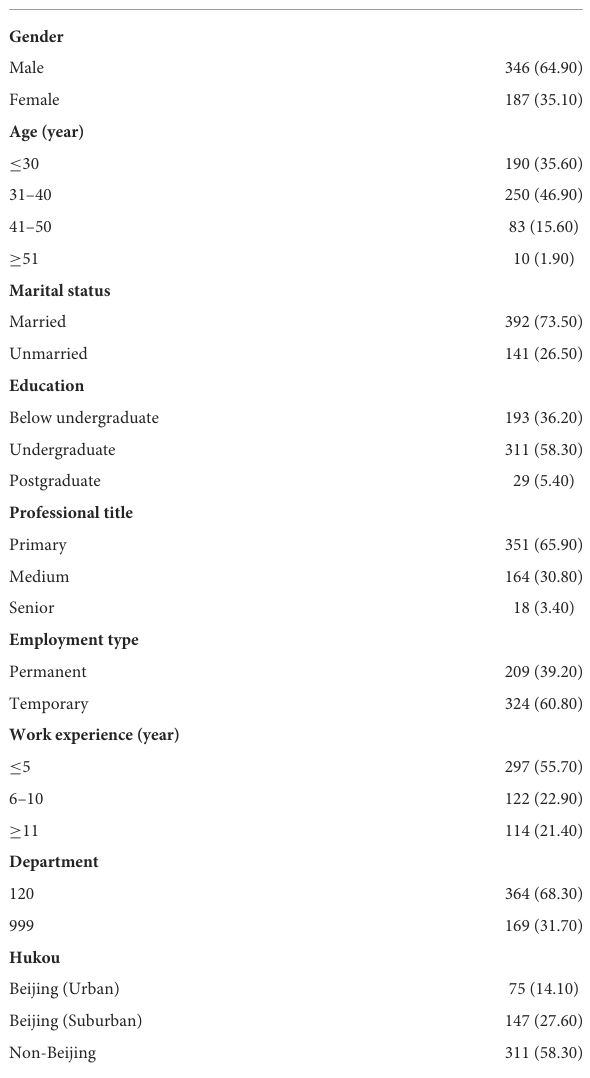
TABLE 1 Respondent distribution by demographics and work